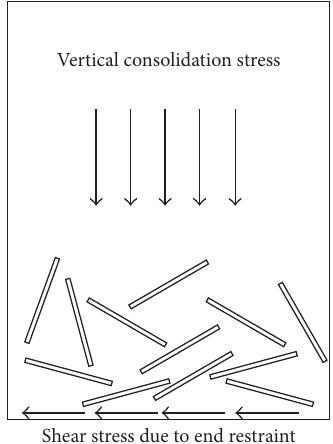
Figure 4: Nonlinear 𝐾 0 of reported clays at a wide range of pressures.